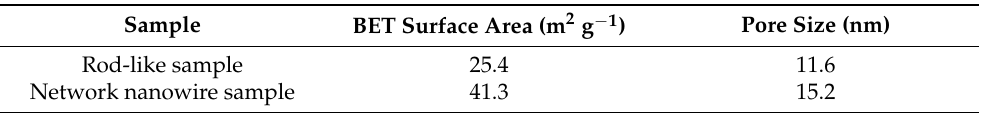
Table 1. BET surface area and pore size distribution of the rod-like and network nanowire sample from N 2 adsorption and desorption